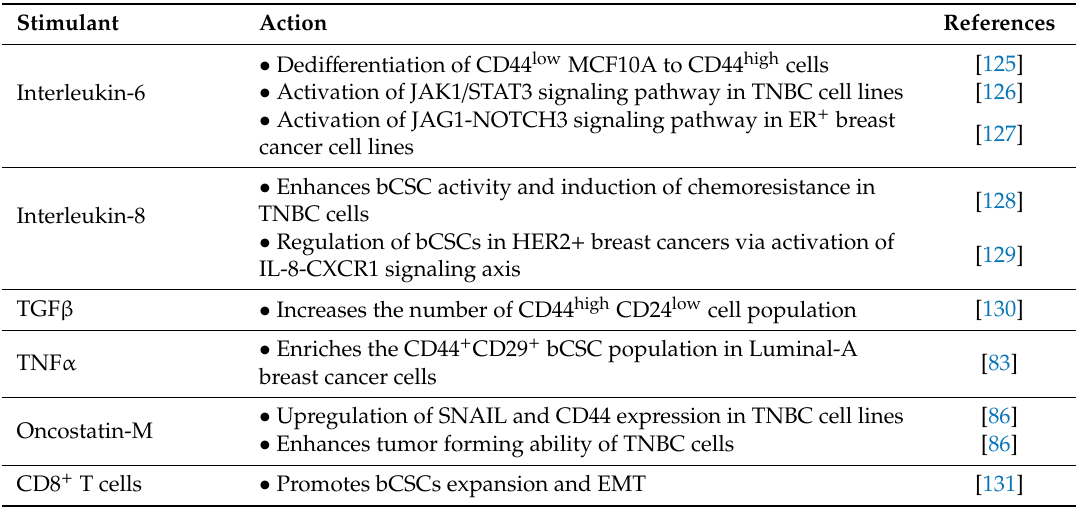
Table 1. Summary of the role of cytokines, immune cells, and stromal cells in regulating breast cancer stem cell (bCSC) activity in the tumor